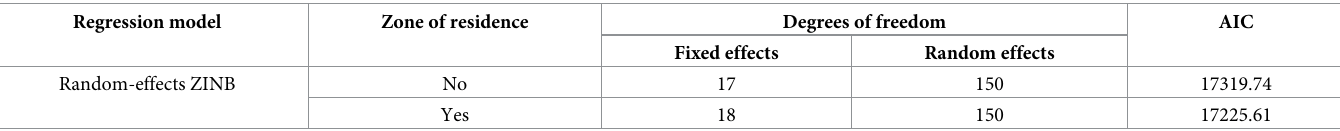
Table 1. Degrees of freedom and Akaike information criterion (AIC) values for the RE-ZINB regression models fitted to empirical data. Regression